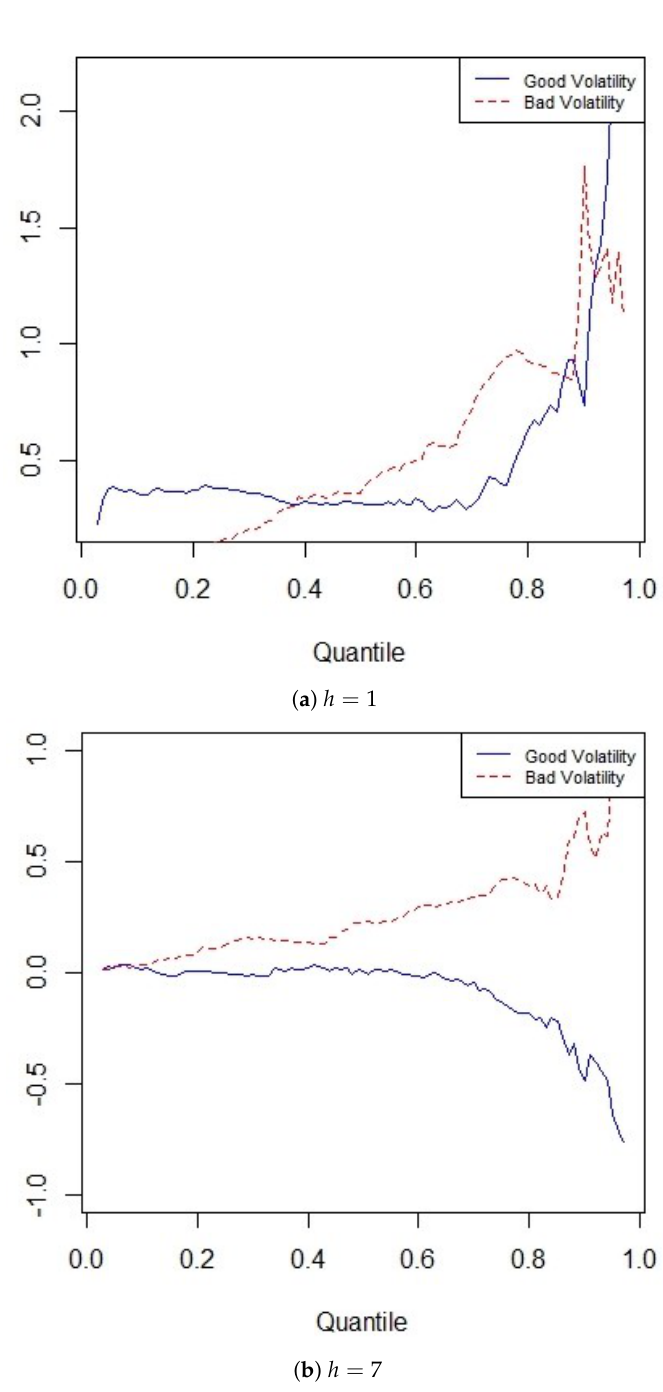
Figure 4. Good and Bad Volatility for ( a ) h = 1 and ( b ) h = 7 forecast horizons. Figures 7 and 8 present the quantile regression results for the 1-day and 7-day horizons based on Model 5. The results are similar compared with the OLS results. The interaction term is close to zero and insignificant across all quantiles for the 1-day ahead horizon. For the 7-day ahead horizon, we find that the lagged interaction term is significantly negative but small across most quantiles except for very high quantiles for which the coefficients increase towards − 1 confirming the strong effect of negative shocks or bad volatility on future volatility as also reported in Figure